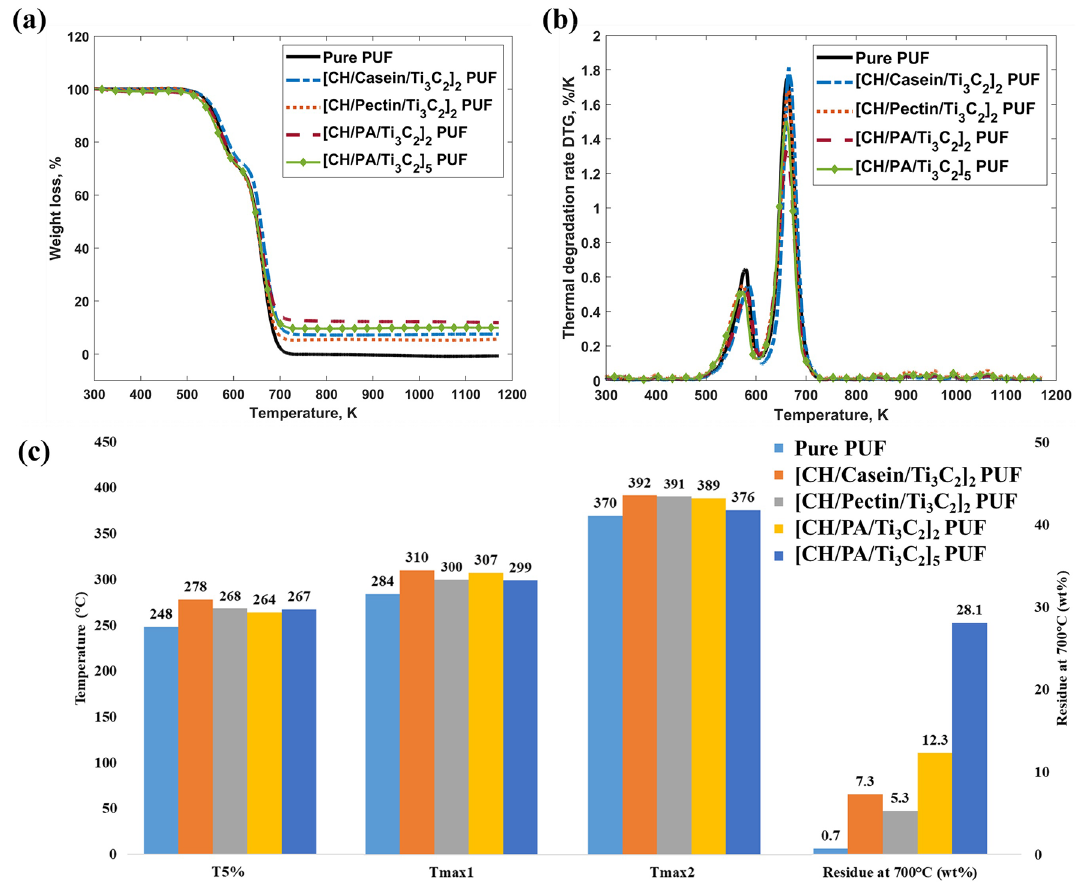
Figure 3. ( a ) TG, ( b ) DTG and ( c ) summarised TGA results of neat PUF and PUF coated with CH/casein/ Ti 3 C 2 , CH/pectin/Ti 3 C 2 , and CH/PA/Ti 3 C 2